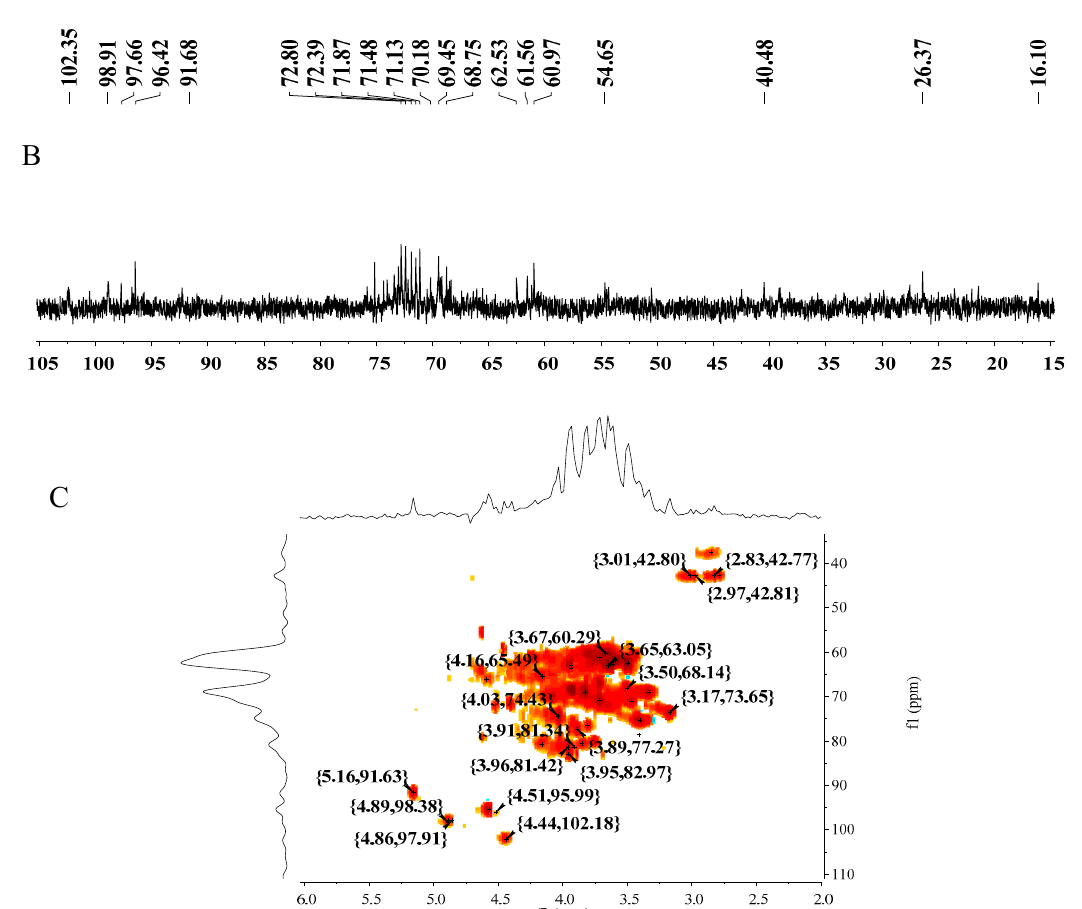
Figure 5. 1D and 2D NMR spectra of PSPE. ( A ) 1 H NMR spectrum; ( B ) 13 C NMR spectrum; ( C ) HSQC spectrum.